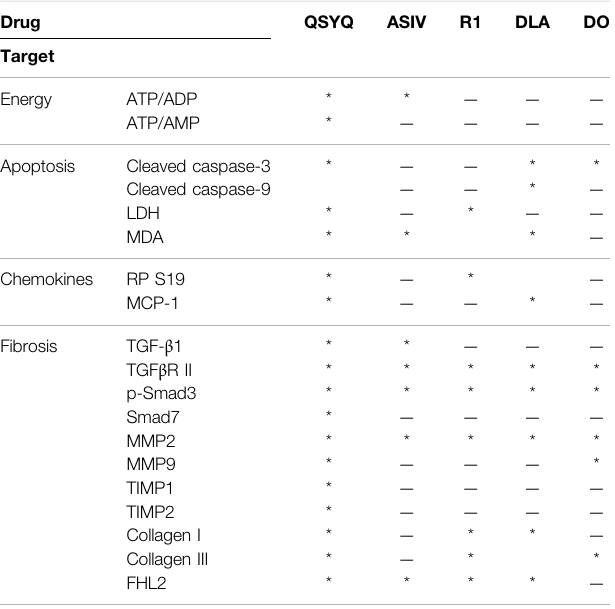
TABLE 1 | Targets of QSYQ and its main ingredients on pressure overload- induced cardiac fi brosis. Drug QSYQ